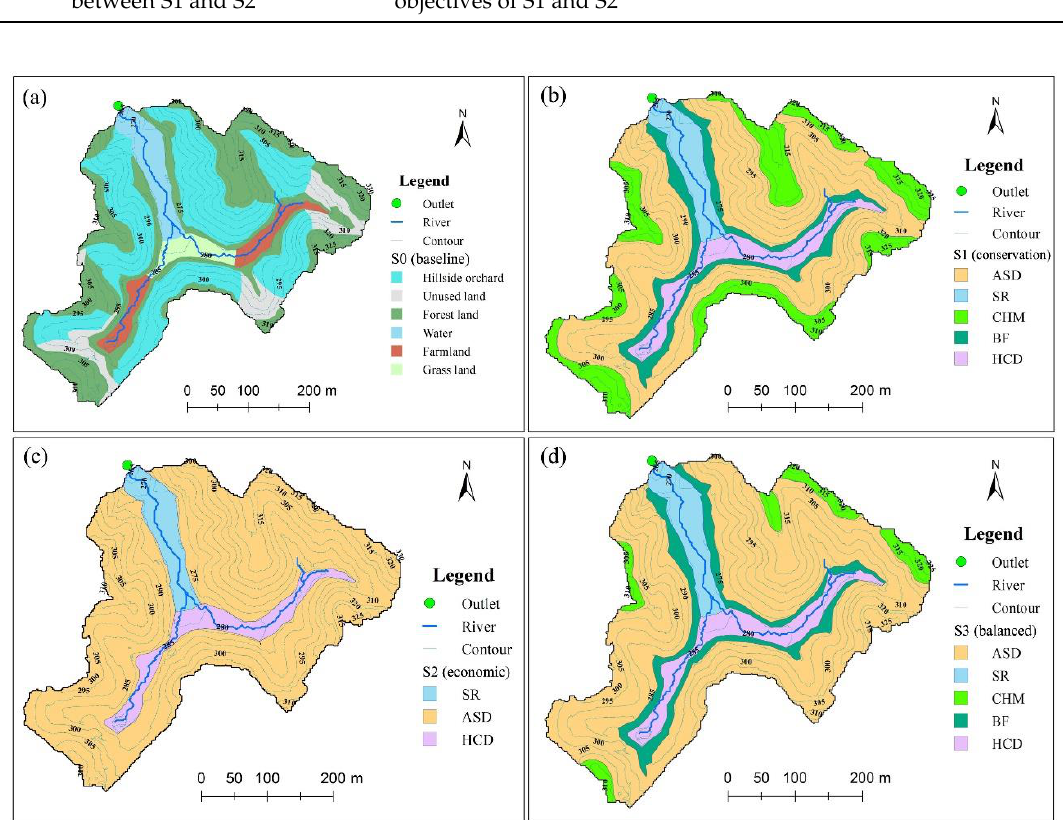
Figure 3. The placements of SWC practices of baseline scenario and alternative scenarios. ( a ) The distribution of land-use types in S0 (baseline). ( b ) The distribution of SWC practices in S1 (conservation). ( c ) The distribution of SWC practices in S2 (economic). ( d ) The distribution of SWC practices in S3 (balanced).